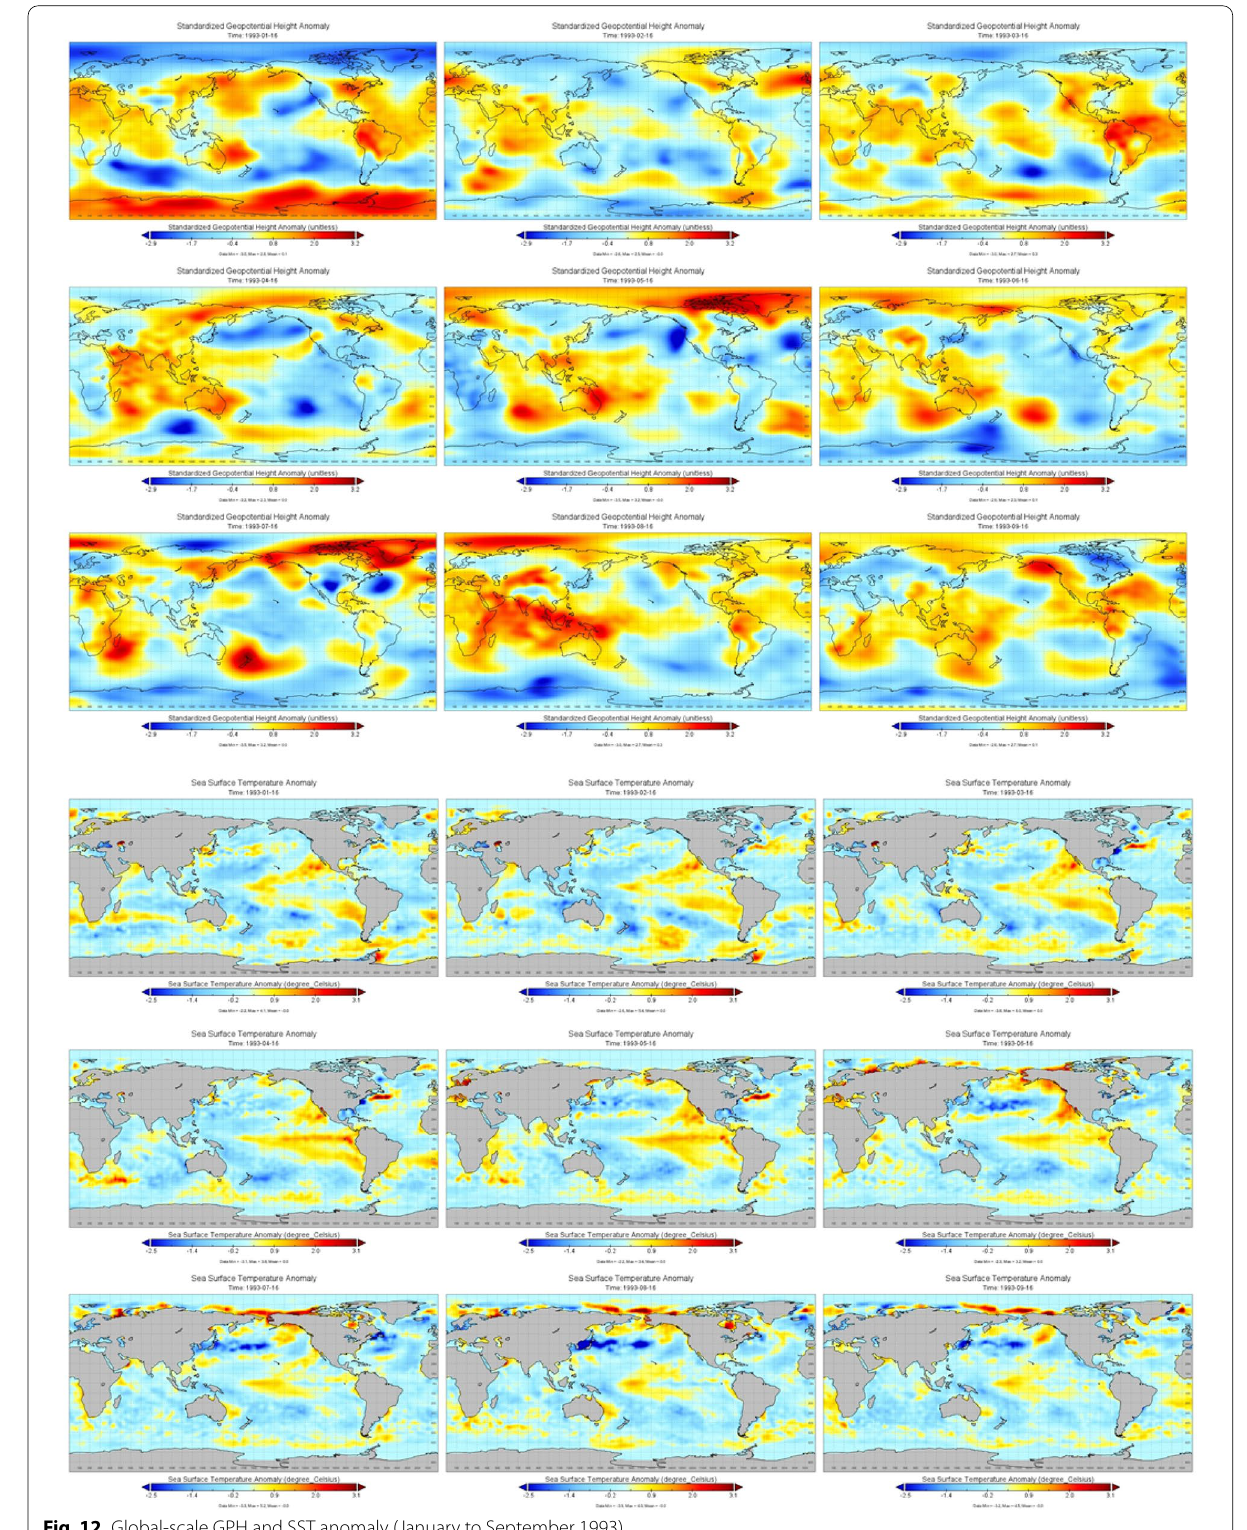
Fig. 12 Global-scale GPH and SST anomaly (January to September